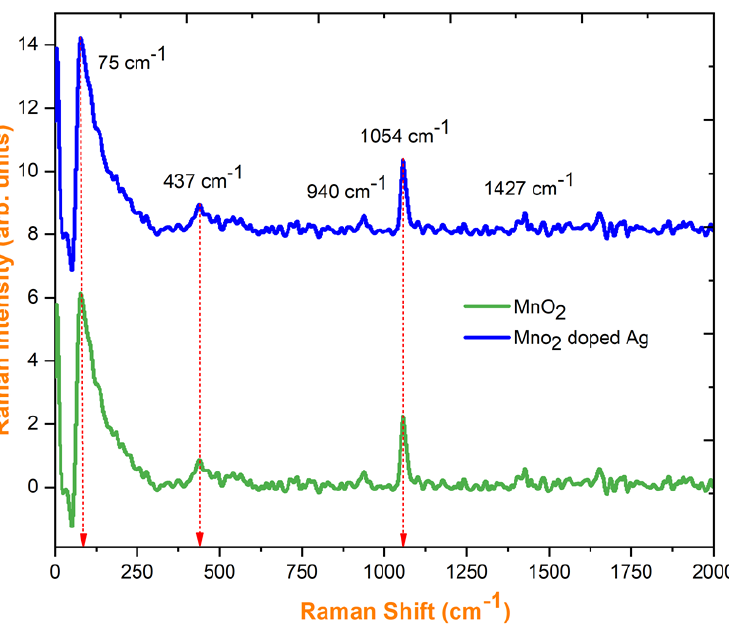
Figure 6. Raman spectrum of synthesised pure MnO 2 and MnO 2 doped with Ag nanoparticles.